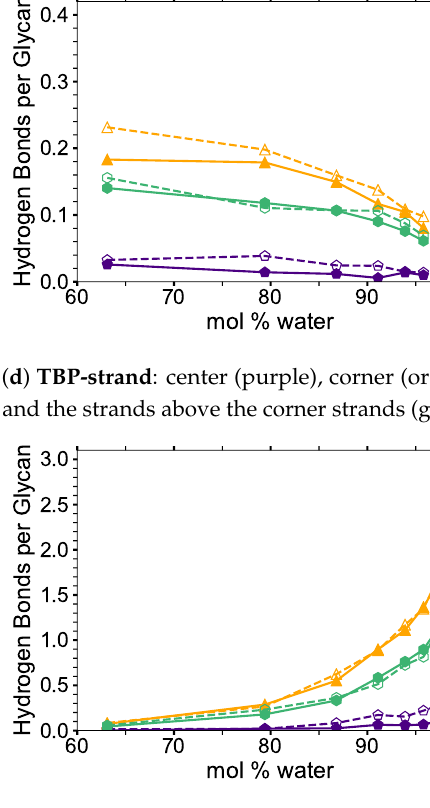
( e ) Water-strand : first (dark pink) and second ( f ) Water-strand : center (purple), corner (orange), layer strands (brown and light blue). and the strands above the corner strands (green). Figure 7. Average solvent hydrogen bonding comparison between the small and large cellulose bundles at various water concentrations: ( a ) the Cl-strand hydrogen bonds for the first and second layers; ( b ) the Cl-strand hydrogen bonds for the center, corner, and the strands above the corner strands; ( c ) the TBP-strand hydrogen bonds for the first and second layers; ( d ) the TBP-strand hydrogen bonds for the center, corner, and the strands above the corner strands; ( e ) the water-strand hydrogen bonds for the first and second layers; ( f ) the water-strand hydrogen bonds for the center, corner, and the strands above the corner strands. All data points were averaged from 10 to 20ns. The solid lines and filled markers represent the large cellulose bundle, and the dashed lines and unfilled markers represent the small cellulose bundle. The colored strands are matched and compared between the plots for the small and large bundles and the images to identify similar hydrogen bonding behavior based on their locations (see Figure 6a,b for the color-coded images). The black cellulose strands are not